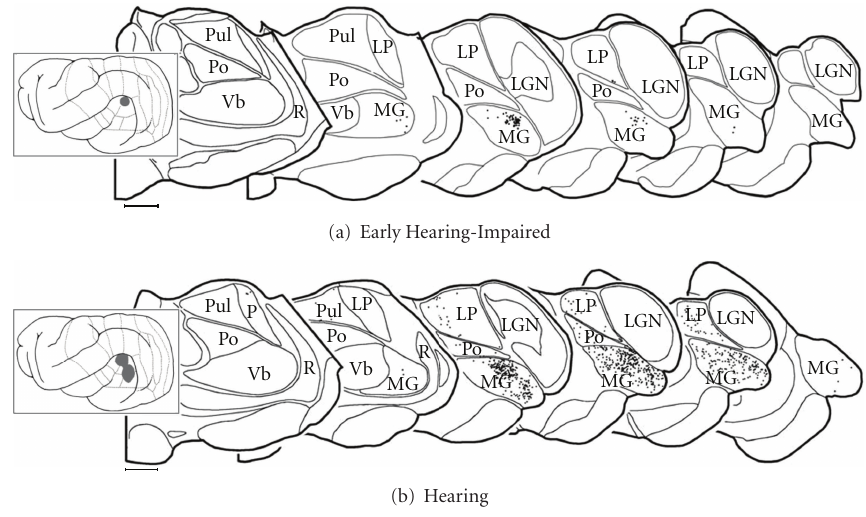
Figure 9: Sources of thalamic inputs to core auditory cortices for early hearing-impaired (a) and normal hearing (b) ferrets. On serially arranged (anterior:left) coronal sections through the thalamus of an early hearing-impaired ferret, tracer injection (BDA; solid grey area) into core auditory cortex produced retrogradely labeled neurons (1 dot = 1 neuron) essentially within the regions regarded as auditory thalamus: in the medial geniculate nucleus (MG). No retrgradely labeled neurons were identified in somatosensory (Vb) or visual (LGN) thalamus although a few were found in the border of the lateral posterior (LP) and posterior (Po) nuclei. Although a larger injection in a hearing animal encroached on the secondary auditory fields, the thalamic labeling was focused on the MG, with lesser connectivity with the LP and Po; no labeled neurons were observed in somatosensory (Vb) or visual (LGN) thalamic nuclei. Hearing controls replotted from